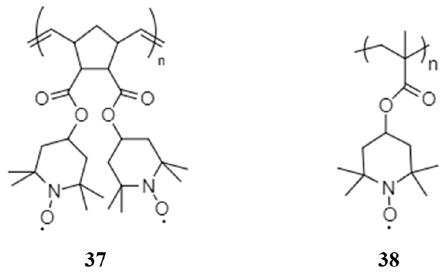
Figure 7. ( a , b ) XRD patterns and ( c ,d) charge and discharge profiles at a current density of 20 mA ꞏ g − 1 of crystalline oligopyrene ( a , c ) and amorphous oligopyrene ( b , d ) as candidate cathode materials for sodium ‐ ion batteries; Inset of ( c ) shows the 2nd charge and discharge profile to indicate a large overpotential; Inset of ( d ) shows the differential capacity (dQ/dV) curves for the 2nd and 10th cycles. Adapted from [68], with permission from © 2013 Elsevier